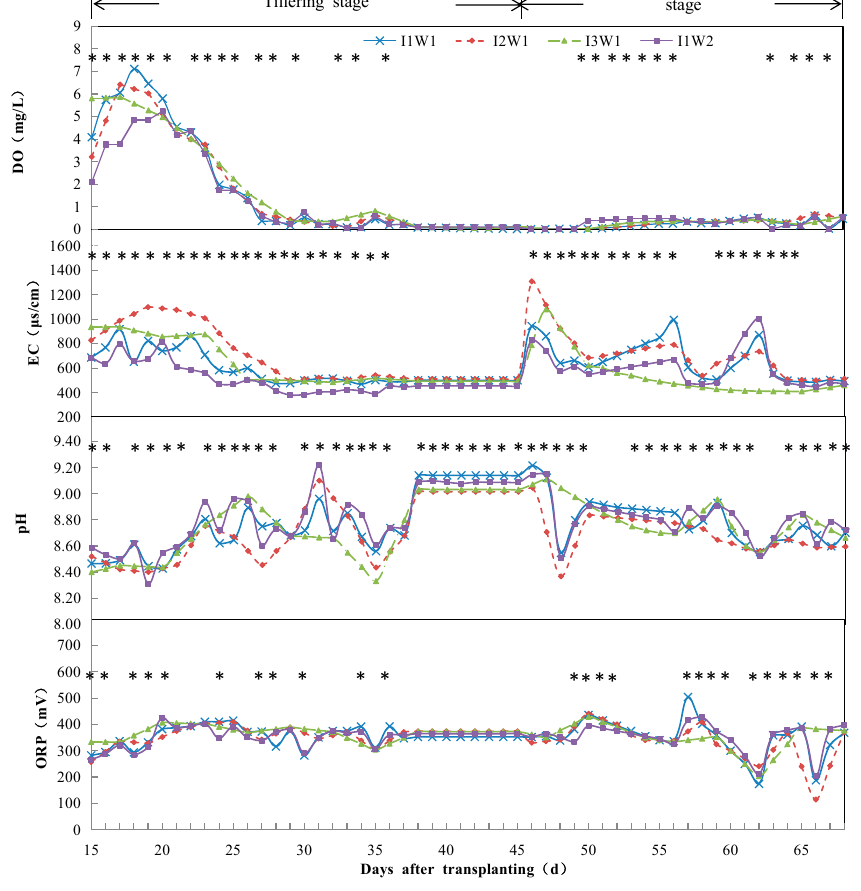
Figure 1. Temporal variations over the growing season in water quality indexes for surface discharge in different irrigation treatments. DAT denotes days after transplanting; DO means dissolved oxygen; EC means electrical conductivity; pH means potential of hydrogen; ORP means oxidation-reduction potential. mg/L means milligrams per liter; μ S/cm means microsecond per centimeter; mV means millivolt. I1W1 represents shallow–frequent irrigation with aquaculture wastewater; I2W1 represents shallow–wet irrigation with aquaculture wastewater; I3W1 represents flooding irrigation with aquaculture wastewater; I1W2 represents shallow–frequent irrigation with fresh water. Asterisks indicate where means of one treatment EC value was significantly different from another EC value (Duncan test, p ≤ 0.05).